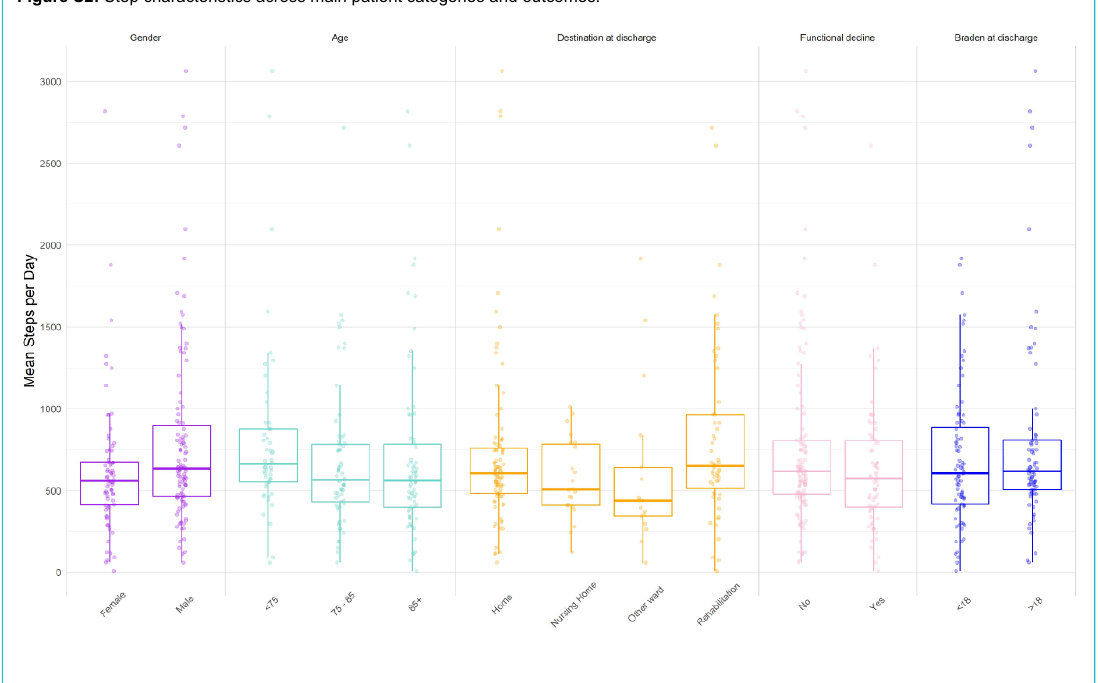
Figure S2: Step characteristics across main patient categories and